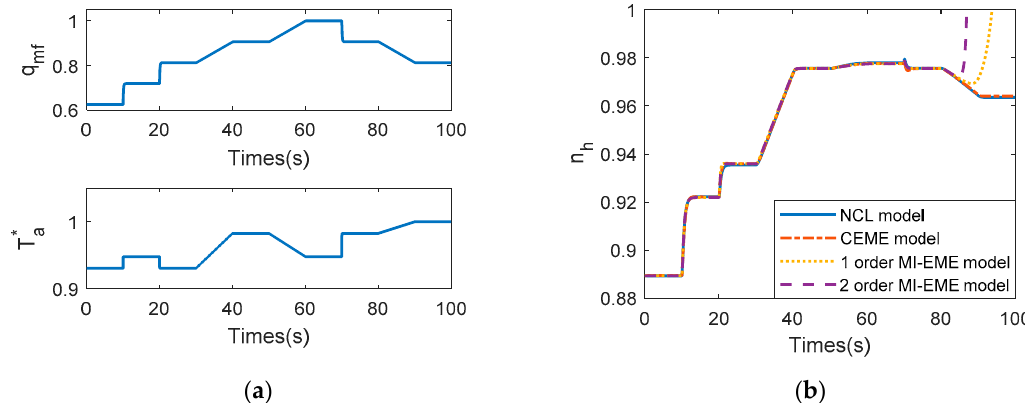
∗ a in test set; ( b ) n h variations in test